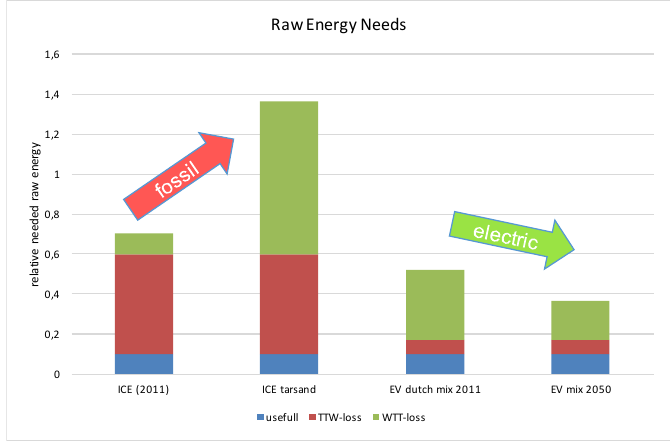
Figure 4. Energy efficiency e-mobility in the Netherlands. Reproduced with permission from [12].